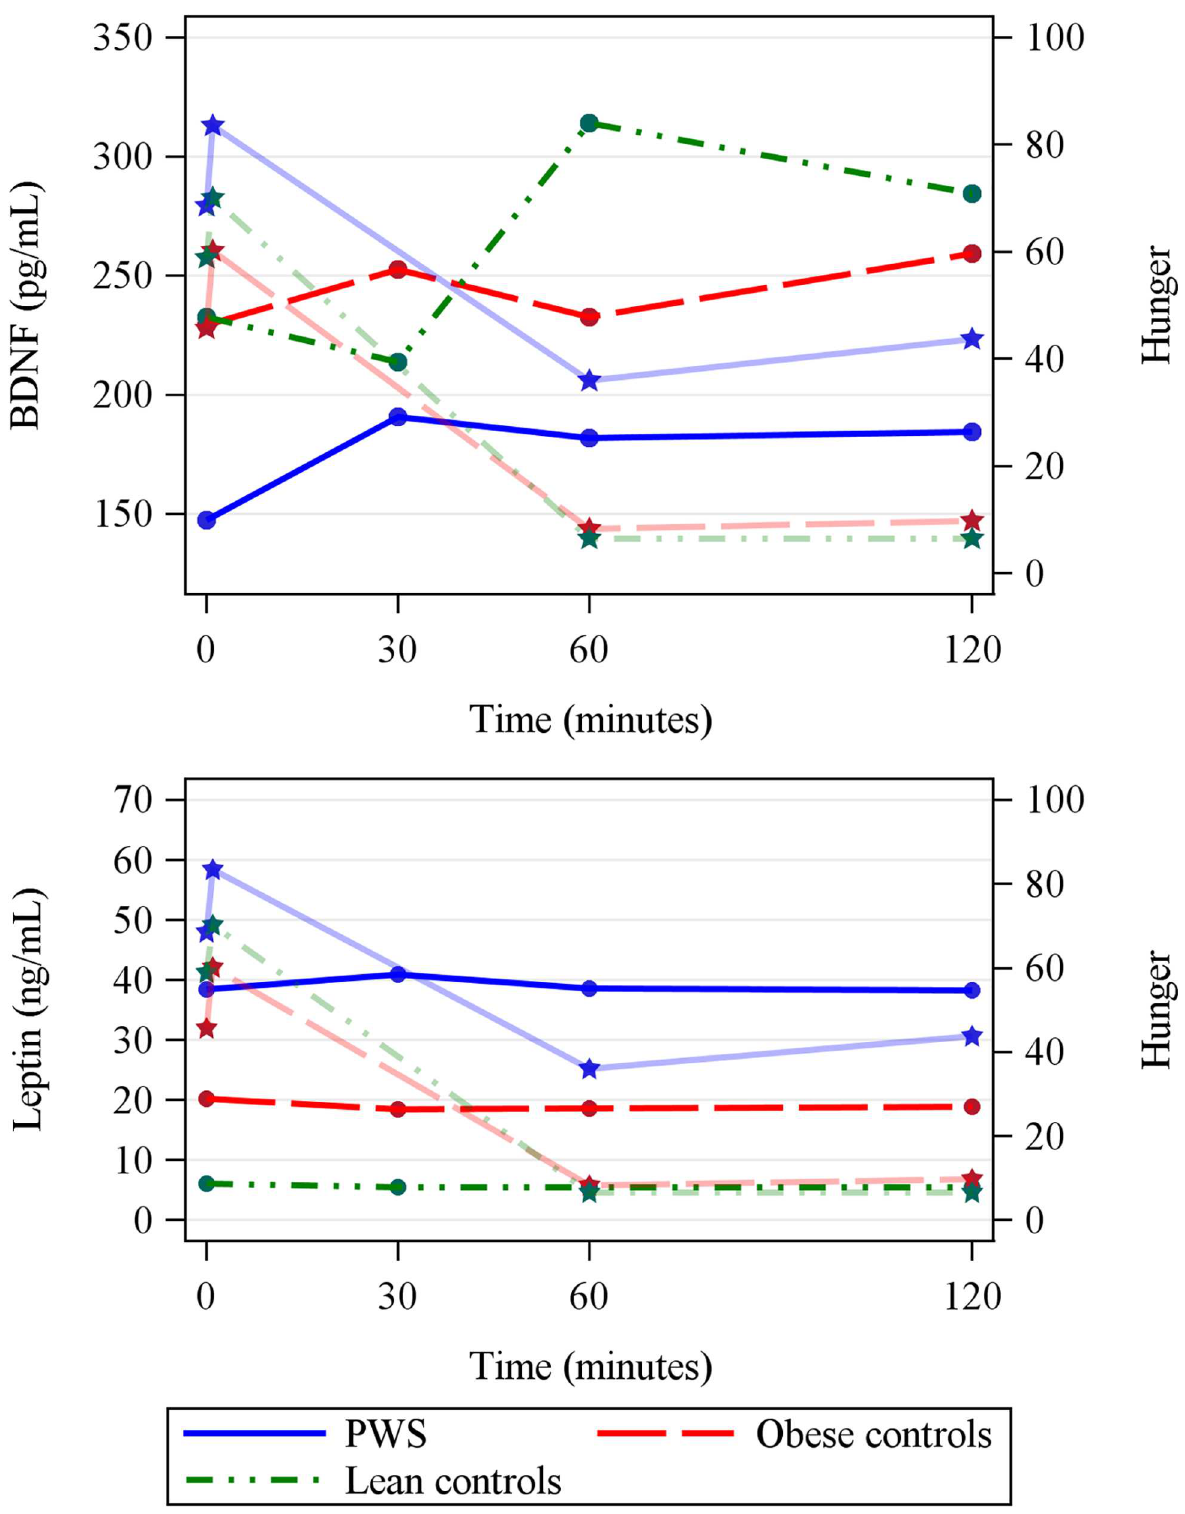
Fig 4. Fasting and postprandial plasma Brain-derived neurotrophic factor (BDNF) (A) and leptin (B) levels (circles) in the three groups, overlaid with hunger score (stars) over time. Note that postprandialBDNF peak in lean controls coincides with the lowest hunger score. PWS = Prader Willi Syndrome. Hunger was quantifiedon a visual analoguescale rangingfrom 0 to 100.